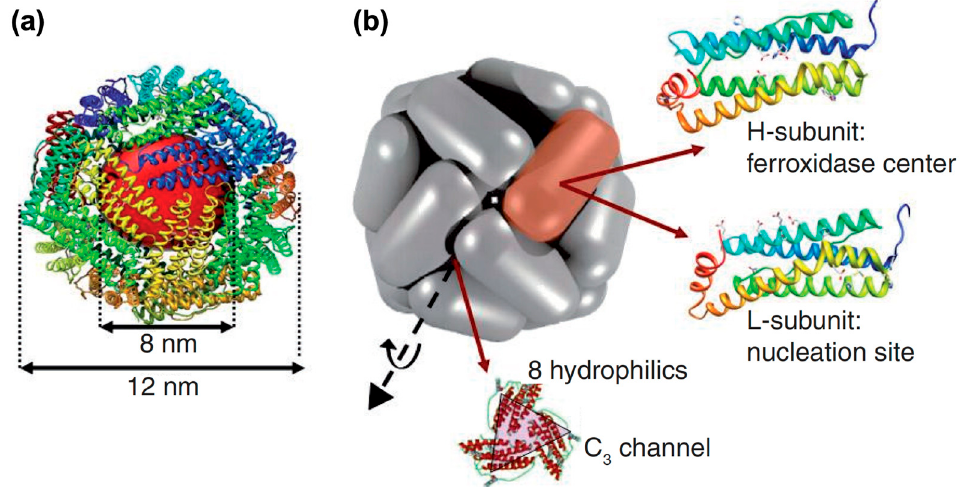
Figure 1. The structure of native ferritin: ( a ) The spherical cage and iron core of ferritin; ( b ) ferritin is composed of H chain subunits and L chain subunits, with 8 hydrophilic channels, which formed a 3-fold axes. Reprinted with permission from Ref 7. Copyright 2010 Newlands Press Ltd.